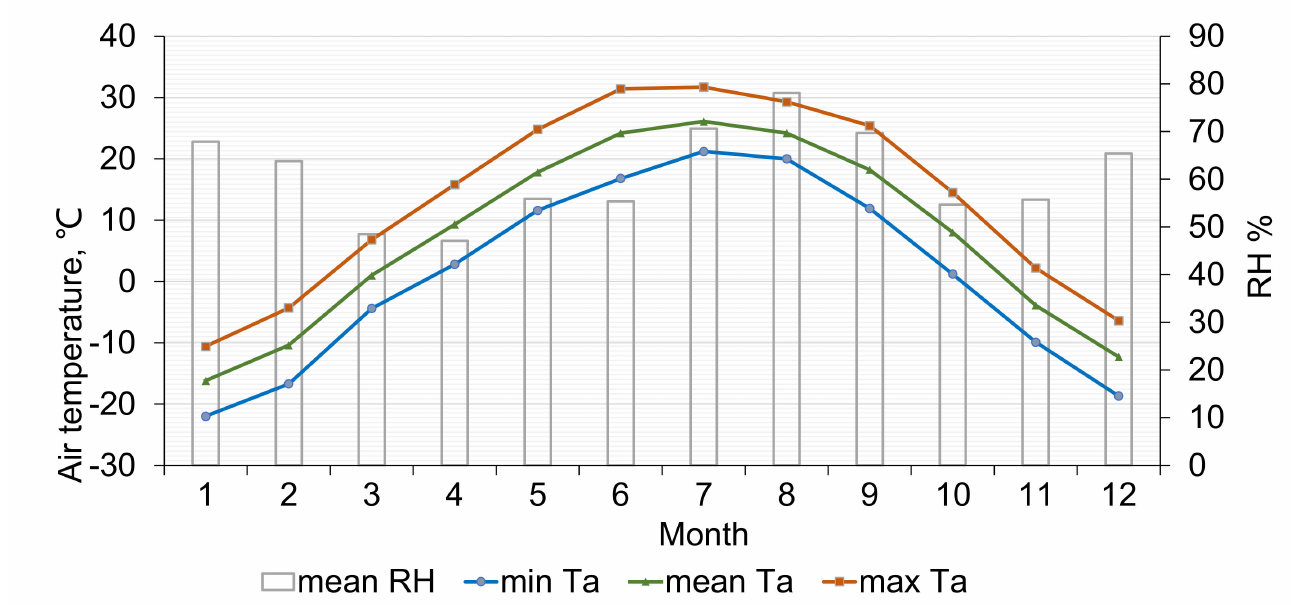
Figure 1. Monthly mean/maximum/minimum air temperature and mean relative humidity in Fuxin from 1971 to 2003. Source: Meteorological database for thermal environment analysis of Chinese